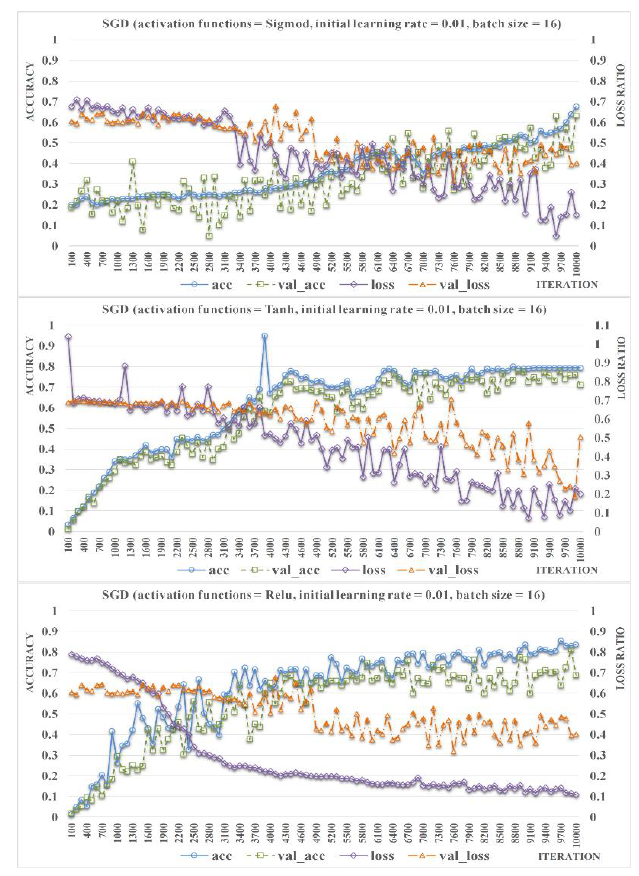
Figure 5. Comparison of the accuracy rate and the loss rate of ResNet-Locust-BN based on different activation functions (initial learning rate = 0.01, batch size = 16).